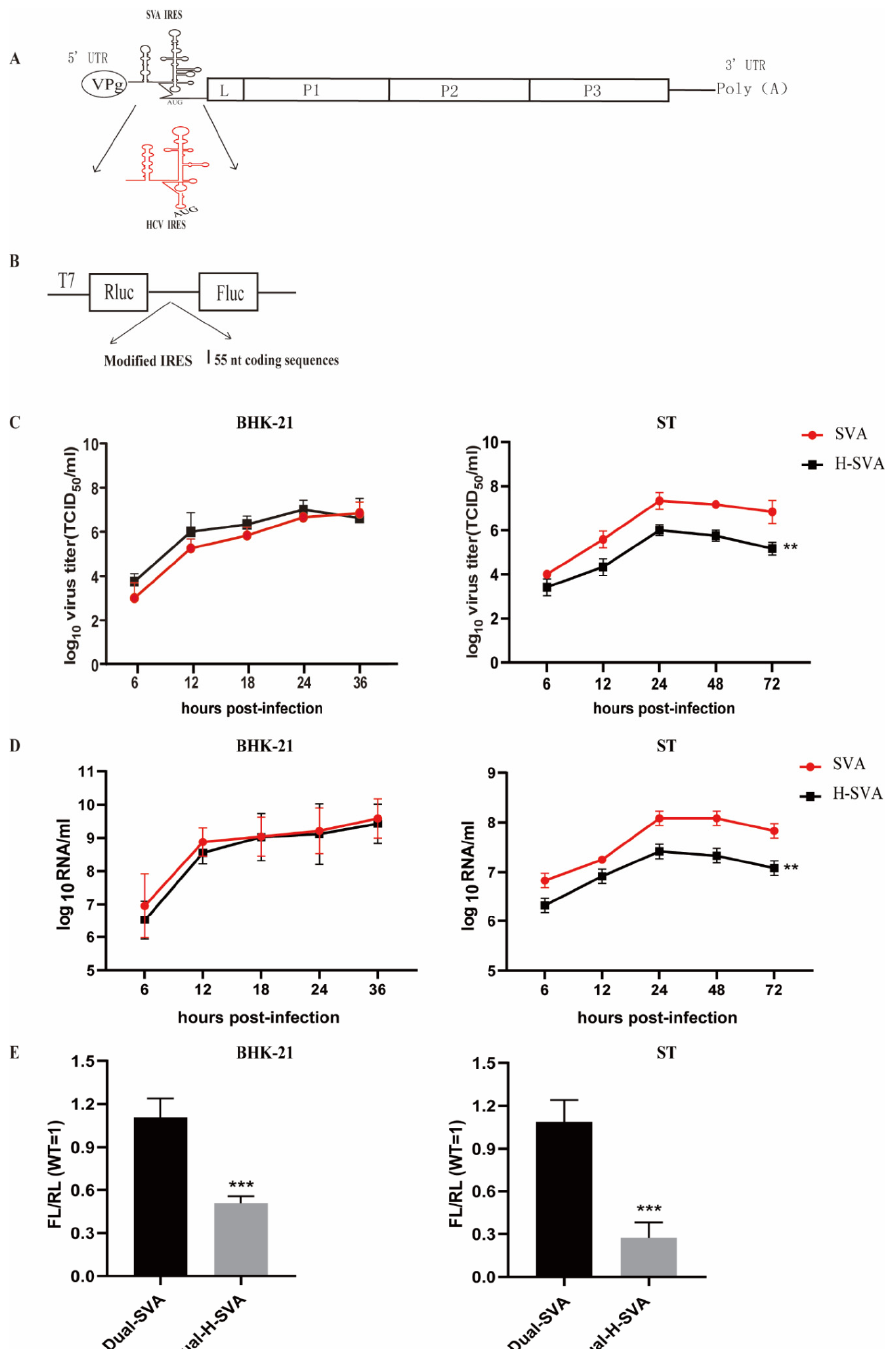
Figure 1. Construction and characterization of WT SVA and the IRES-replaced chimeric virus H-SVA. ( A ) Schematic diagram of the construction of SVA IRES replaced by HCV IRES. The black graph depicts SVA genome. The SVA IRES and HCV IRES is indicated by black and red graph, respectively. BHK-21 and ST cells were infected with SVA or H-SVA at an MOI of 0.01. ( B ) Schematic diagram of the construction of a dual luminescent reporter plasmid. Growth curves were determined by TCID 50 assay, ( C ) and the viral RNA copies were determined by RT-qPCR ( D ). ( E ) IRES activity of WT SVA and H-SVA. The dual-luciferase reporter plasmids for WT SVA or H-SVA RNA were transfected into BHK-21 or ST cells. At 12 h post-transfection, the RLuc and FLuc activities in the cell lysates were quantified. Data in panels B, C, E are presented as the mean ± SD ( n = 3). Significance of the changes were analyzed by Student’s t -test and indicated by *** p < 0.001, ** p <